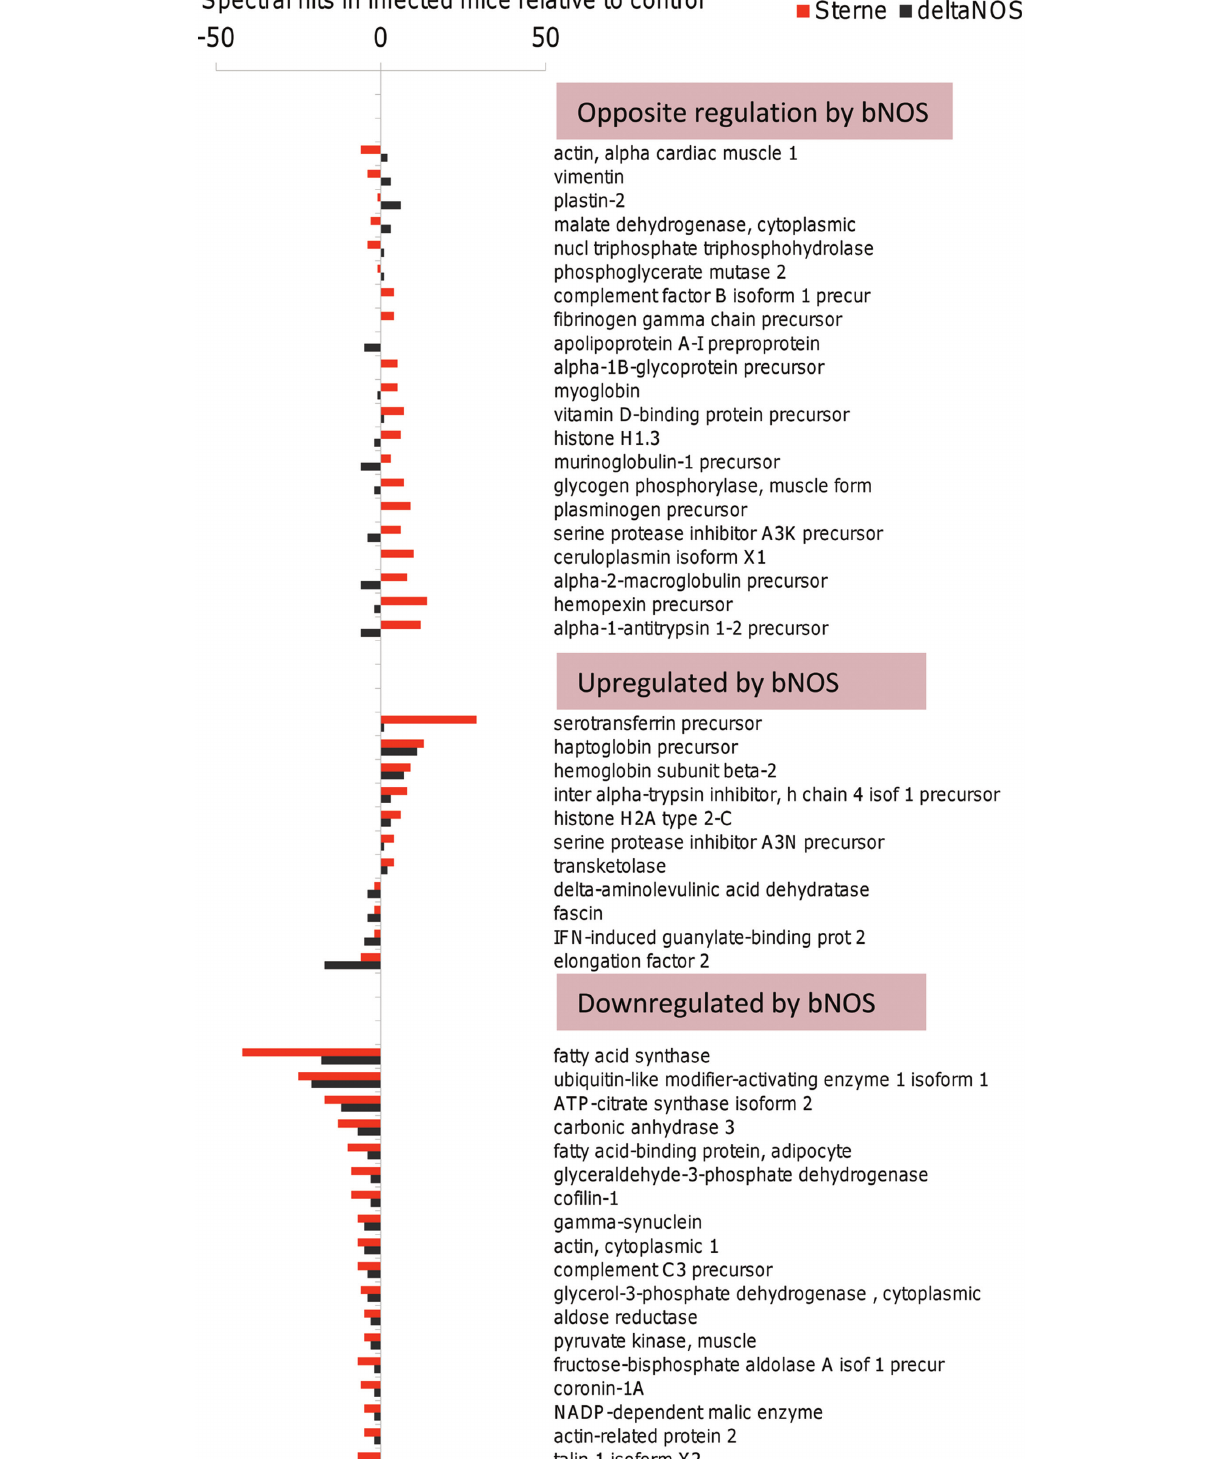
Frontiers in Microbiology |